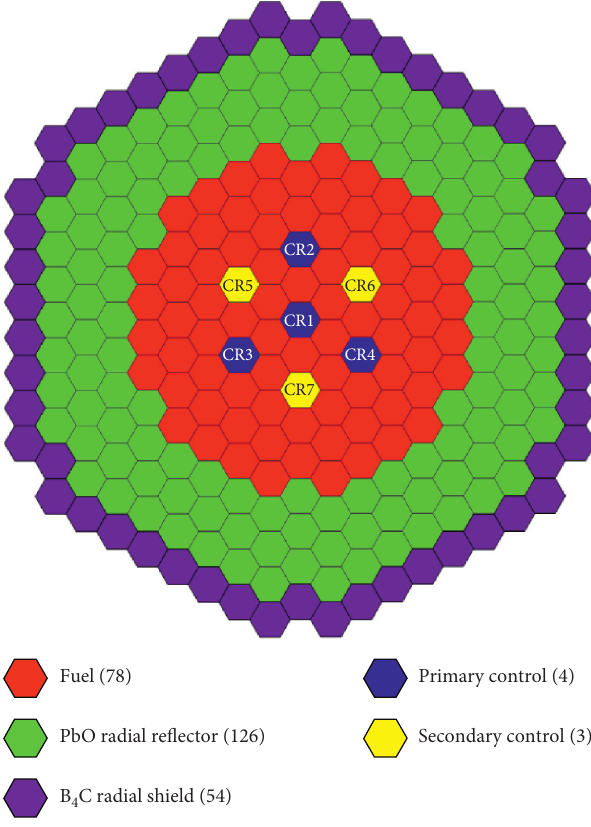
Figure 1: Radial sectional view of B&BR.